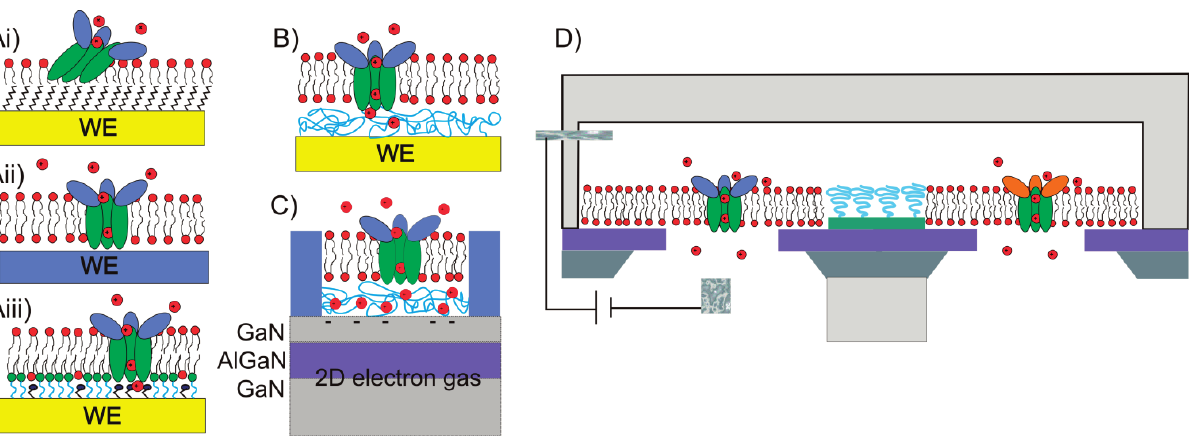
Figure 10. Schematics of different membrane architectures implemented for biosensing redrawn from [148]. ( Ai ) Hybrid bilayer consisting of a self-assembled monolayer and a lipid monolayer which can be self-assembled on moth biosensors; ( Aii ) A solid-supported lipid bilayer suitable for cantilever (acoustic), waveguide and silicon nanowire sensors; ( Aiii ) A tethered supported lipid bilayer with spacers suitable for plasmonic and impedance measurements; ( B ) A hydrogel-cushioned lipid bilayer decoupled from the solid support; ( C ) A miniaturized cushioned lipid bilayer gating a field-effect transistor (so-called BIO-FET); ( D ) Nanopore-spanning lipid bilayer for nanoscale optical and electrochemical